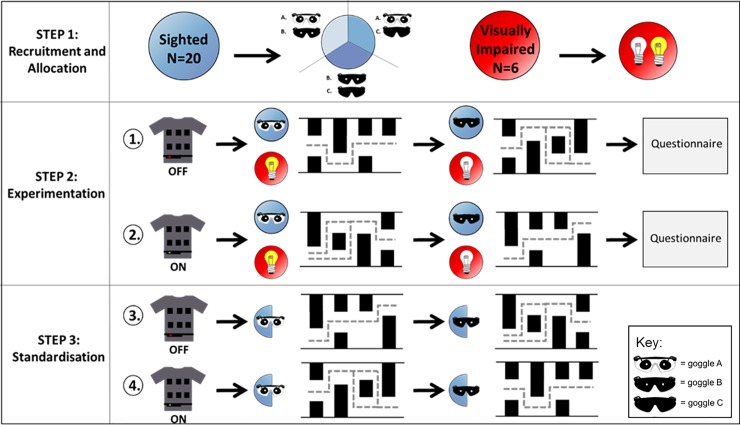
Experimental protocol.Visual representation demonstrating the three steps of the experimental protocol. Sighted subjects (blue) were allocated goggles (A-C) to reduce their vision before completing the mazes. Visually impaired subjects (red) completed the mazes in both bright and dim light. Half of the sighted subjects (blue semicircle) repeated the mazes with the variants in a different order.